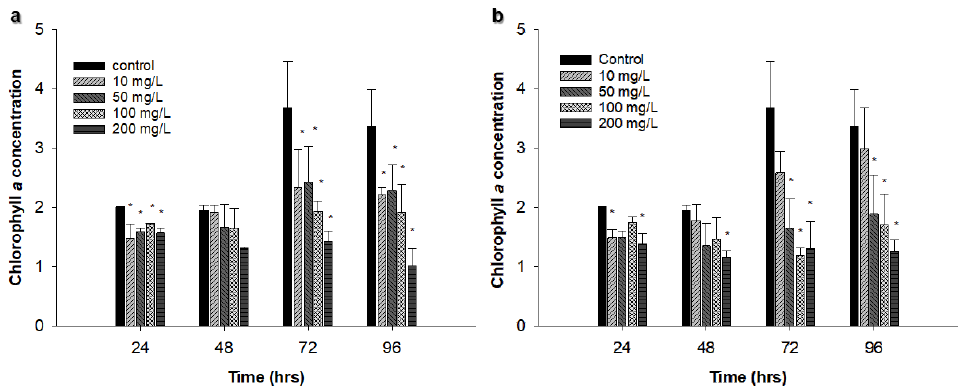
Figure 3. Effect of different concentrations of Ag NPs on Chlorella vulgaris chlorophyll a concentration in µg L −1 : ( a ) 50 nm Ag NPs, ( b ) 100 nm Ag NPs. The experiments were performed in triplicate, and